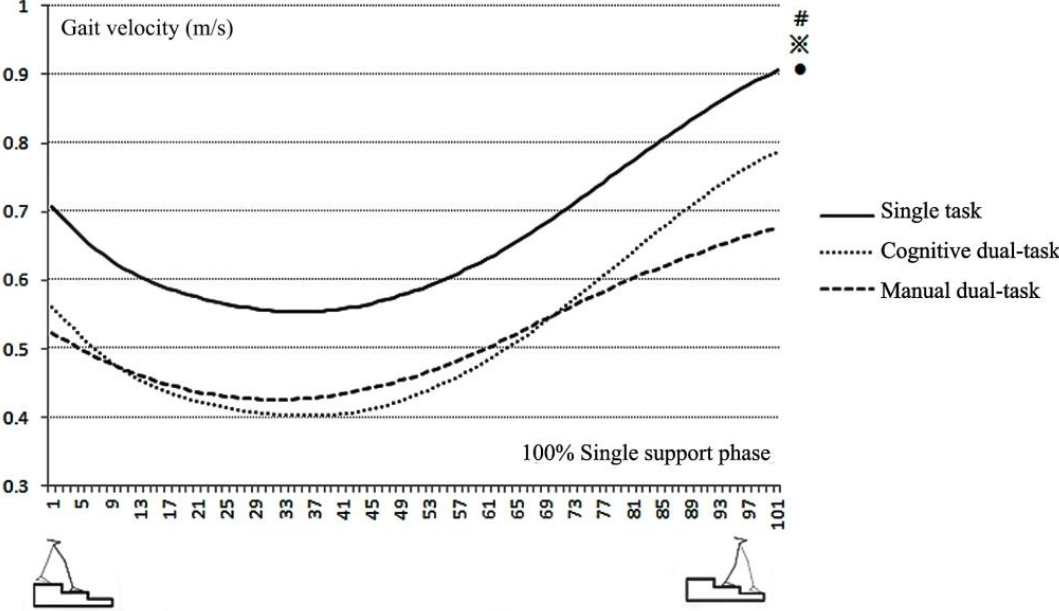
Figure 2. Descending velocity (y) of the single-support phase (x) during single-task and cognitive and manual dual-task conditions; ＃ Significant difference between single-task and cognitive dual-task conditions; ※ Significant difference between single-task and manual dual-task conditions; ● Significant difference between cognitive and manual dual-task conditions.